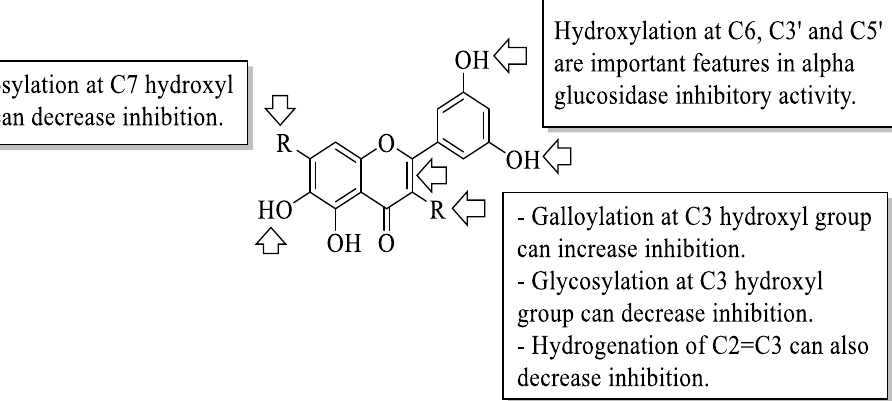
Figure 21. The SAR of flavonoids for α -glucosidase inhibition activity [58].